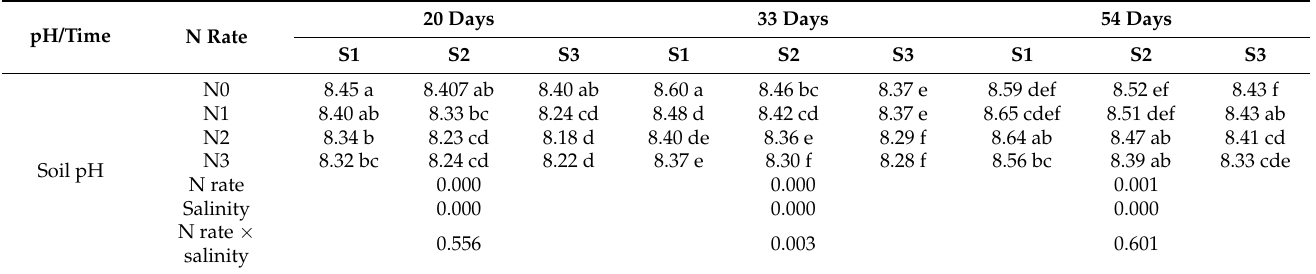
Table 3. Effects of nitrogen application on soil pH 1:5 at different growth stages of winter wheat in various salinity level